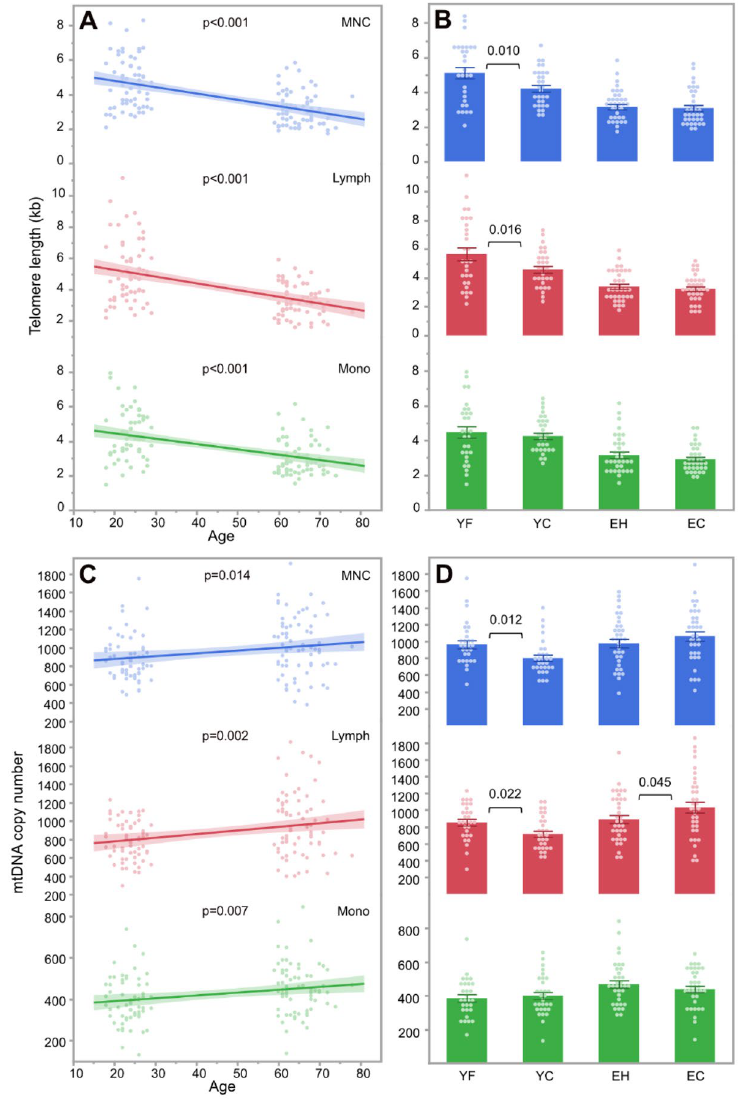
(EH) and elderly controls (EC). Lymph lymphocytes; MNC mononuclear cells; Mono